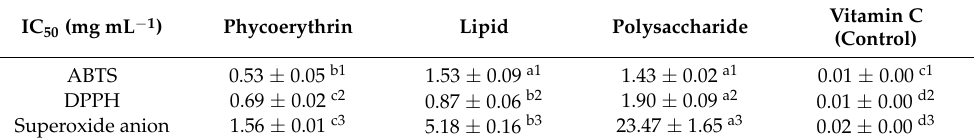
Figure 6. Antioxidant activities of the three extracts of Porphyridium purpureum . ( a ) ABTS scavenging activity of polysaccha- ride, ( b ) DPPH scavenging activity of polysaccharide, ( c ) superoxide anion scavenging activity of polysaccharide, ( d ) ABTS scavenging activity of crude lipids, ( e ) DPPH scavenging activity of crude lipids, ( f ) superoxide anion scavenging activity of crude lipids, ( g ) ABTS scavenging activity of crude phycoerythrin, ( h ) DPPH scavenging activity of crude phycoerythrin, and ( i ) superoxide anion scavenging activity of crude phycoerythrin ( n = 3; data: mean ± SD). Table 4. IC 50 of three crude